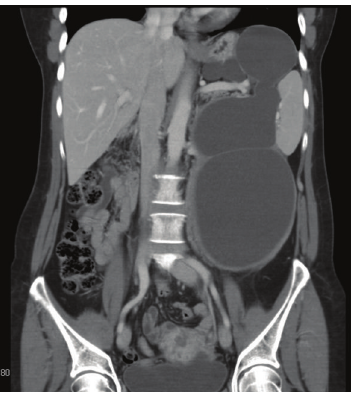
Figure 1: CT scan of the abdomen (coronal view) showing a large cystic mass extending from the diaphragm to the left iliac region.